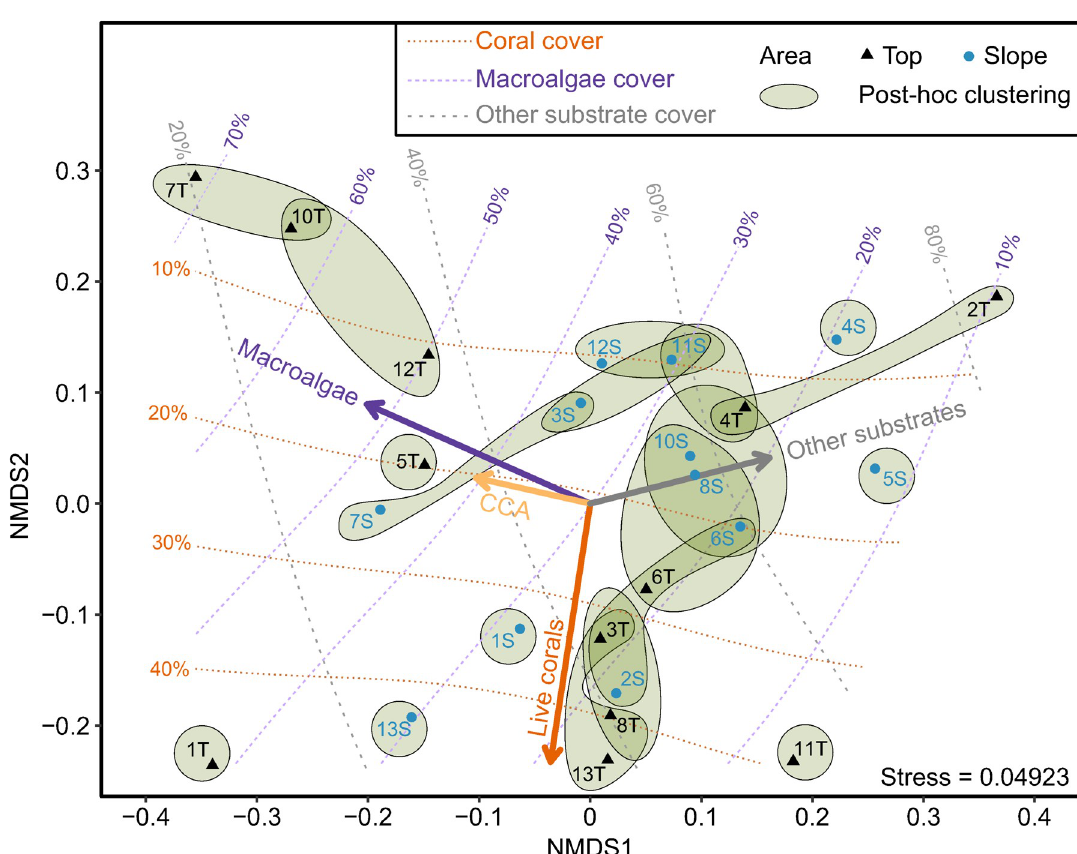
Fig 2. Spatial variation in benthic categories in the Dongsha lagoon. Two-dimensional nonmetric multidimensional scaling (NMDS) of average percent cover of corals, total macroalgae (upright/crustose non-coralline seaweeds and turf), crustose coralline algae (CCA) and other substrate among 24 groups (12 sites × 2 area types). Thick arrows represent the vectors of weighted average scores of benthic categories. Green loops enclose groups with statistically similar composition by clustering analysis based on the Bayesian post-hoc analyses (posterior Cohen’s d > 0.2); a loop enclosing only one group indicates that its composition is significantly different from all other groups. Dashed lines indicate the contours of percent cover projected onto two-dimensional NMDS space.